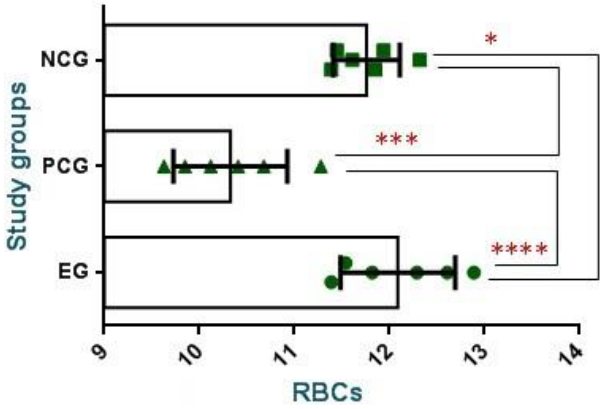
Figure 8. Total results of total RBCs among groups of dogs and the time points. (*), (***), and (****) referred to significant differences between groups as P≤0.05, P≤0.001, and P<0.0001 respectively.